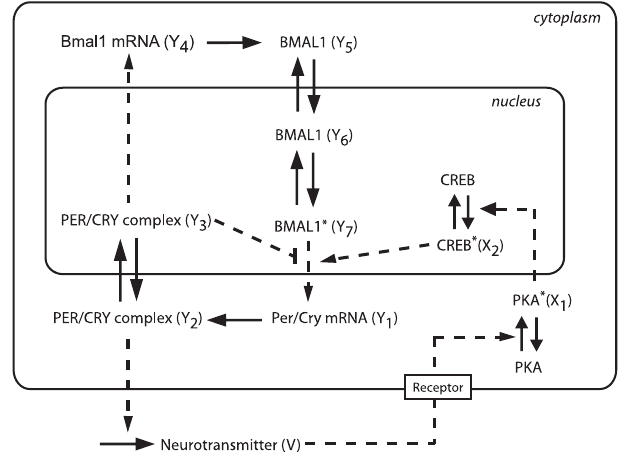
Figure 1. Scheme of the Single-Cell Circadian Oscillator, Including the Coupling Mechanism The intracellular oscillator consists of interlocked positive and negative transcriptional/translational feedback loops. In the negative feedback loop, Per and Cry genes (treated as a single variable) inhibit their own transcription by preventing BMAL1 from promoting Per/Cry transcription. In the positive feedback loop, the PER/CRY complex activates the transcription of their common transcriptional activator, Bmal1 [23]. We assumed that the release of the neurotransmitter in the extracellular medium is activated by PER/CRY. In turn, the neurotransmitter activates a signaling cascade (involving PKA and CREB) that activates Per/Cry expression. In this schematic representation, solid arrows denote transport, translation steps, or phosphorylation/dephosphorylation reactions, while dashed arrows denote transcriptional regulations. The stars indicate the active (phosphorylated or complexed) form of the proteins. For a full reasoning of modeling assumptions see main text and [23].